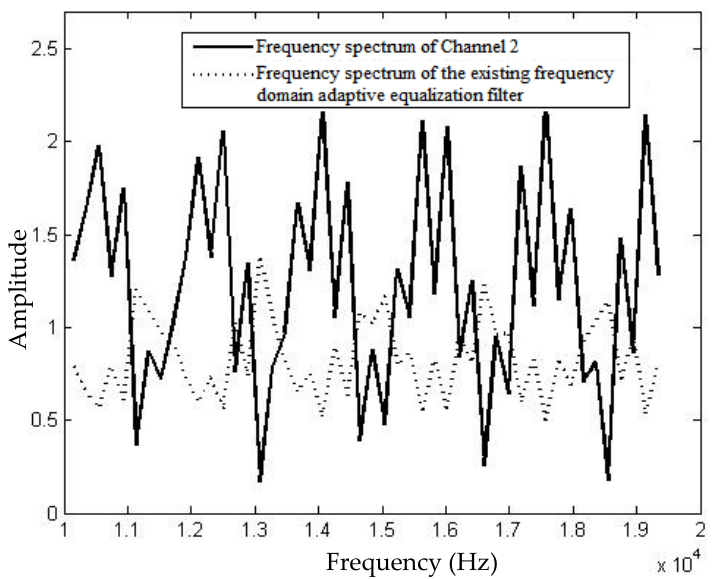
Figure 4. Compensation for Channel 2 with the existing frequency domain equalization algorithm.